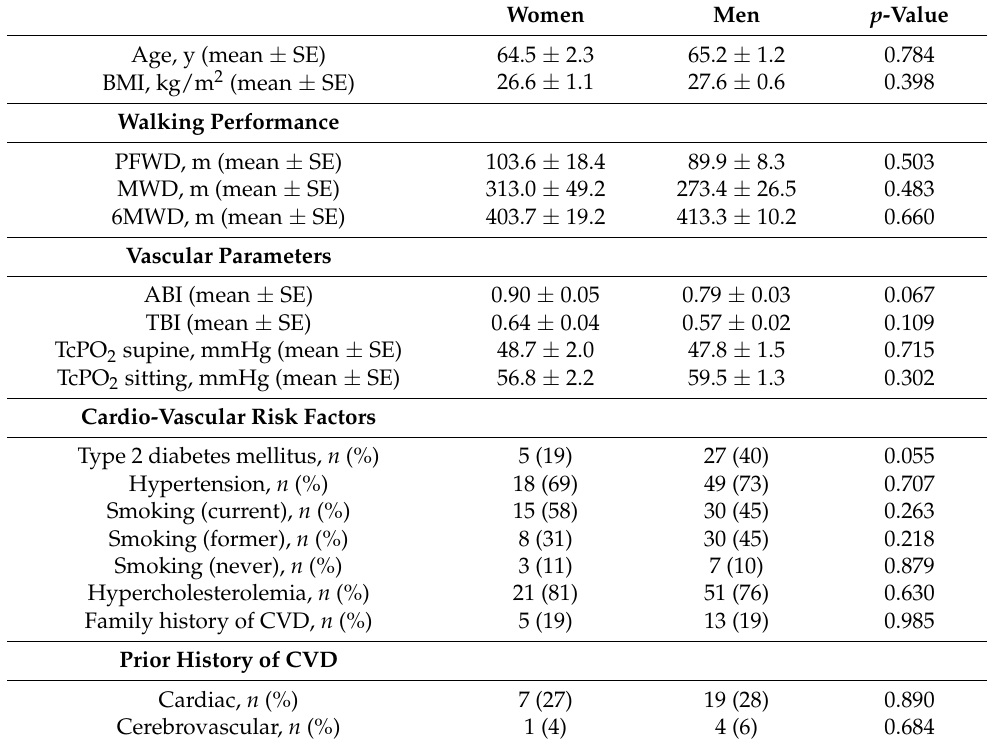
Table 3. Baseline characteristics of men and